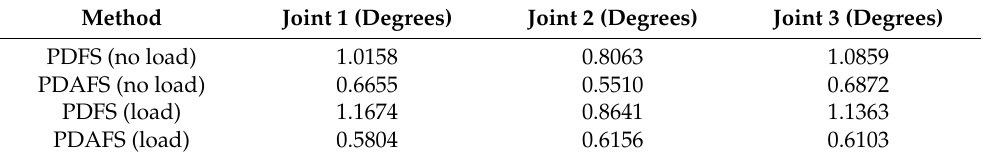
Figure 16. Disturbance torque estimation ( a ) and weight update of ( b ) joint 1; ( c ) joint 2; ( d ) joint 3 from RBFNNs in helix case 1; disturbance torque estimation ( e ) and weight update of ( f ) joint 1; ( g ) joint 2; ( h ) joint 3 from RBFNNs in parabolic case 1. Table 11. RMSE Comparison among the controllers and PDAFS in Parabolic Case 1.